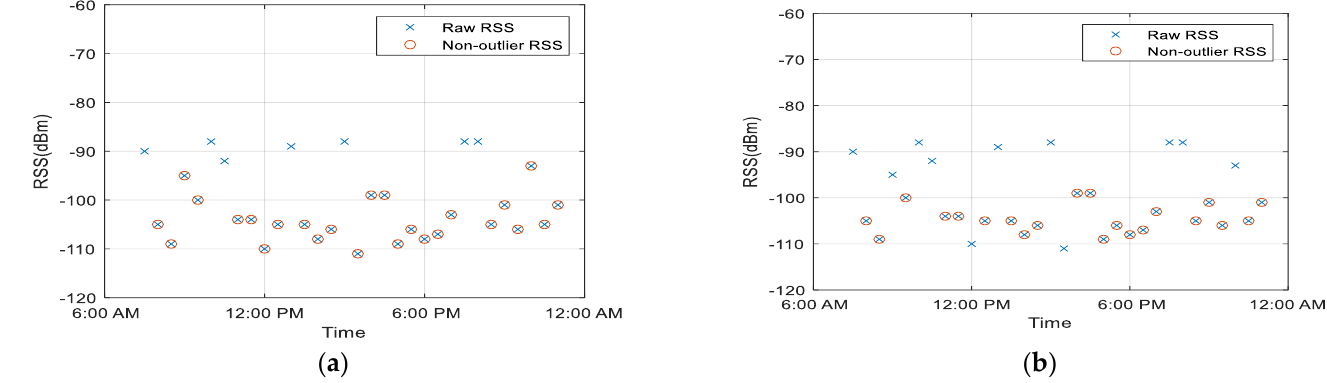
Figure 8 . RSS outlier detection comparison for RSS Dataset 6. ( a ) 𝑆 𝑛 scale estimator, and ( b ) MAD scale estimator.